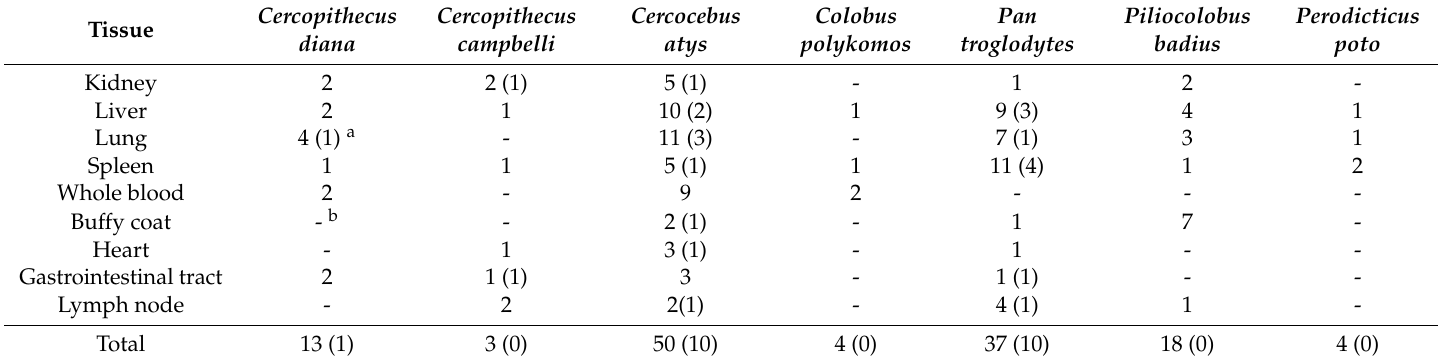
Gastrointestinal tract